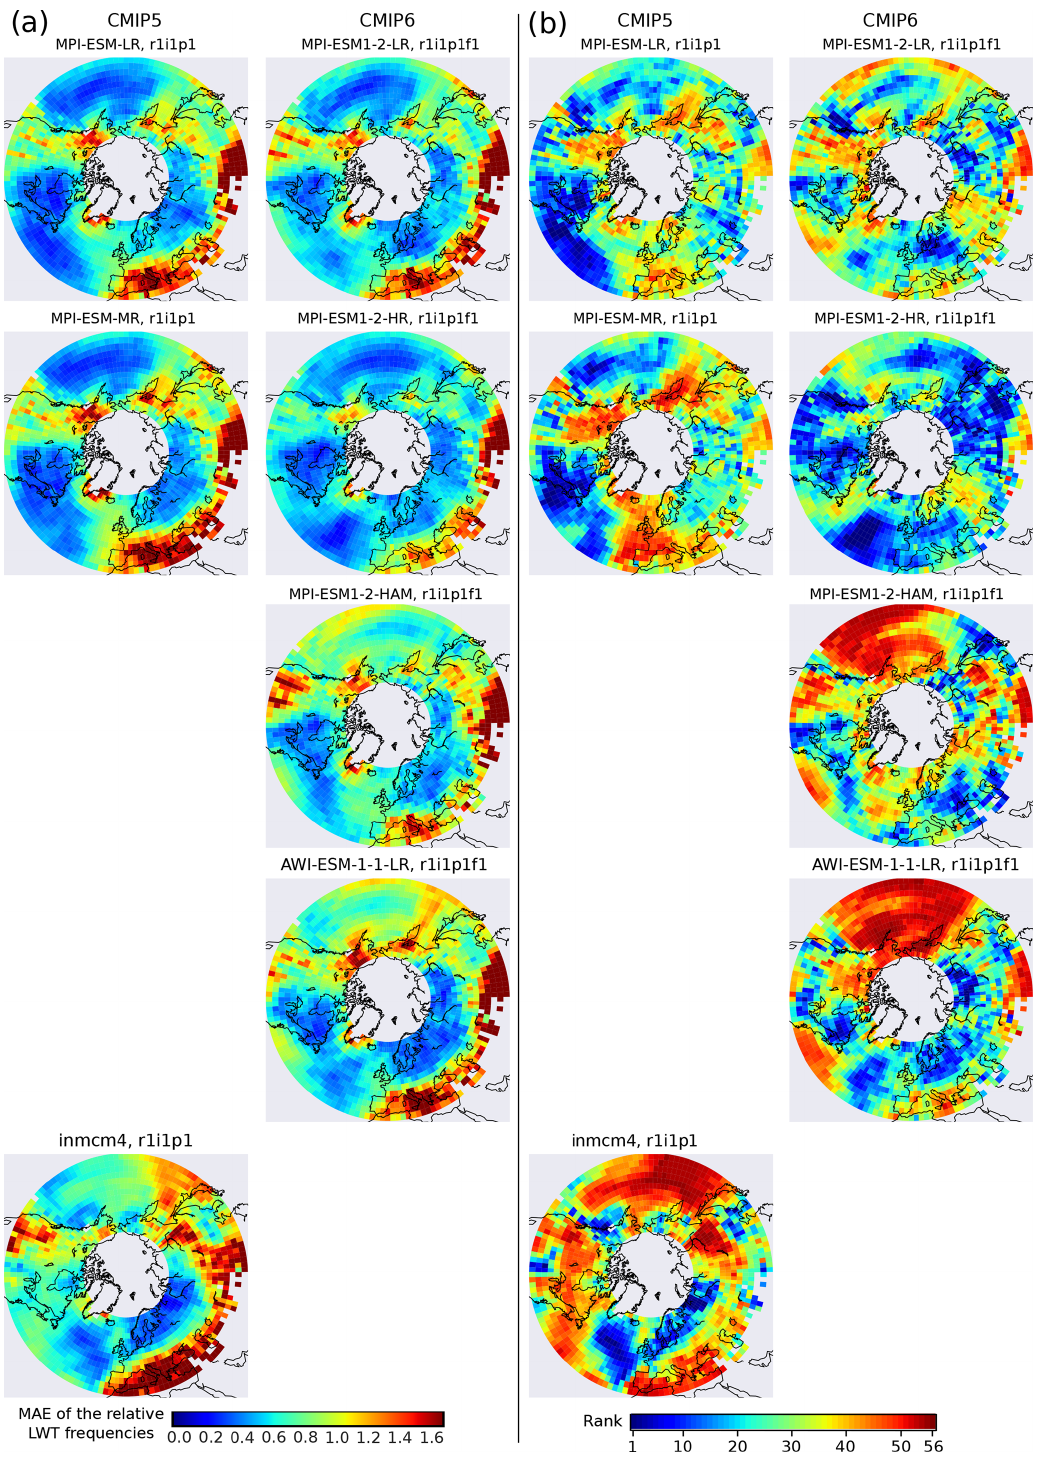
Figure 8. As Fig. 3 but for the MPI, AWI and INM models.